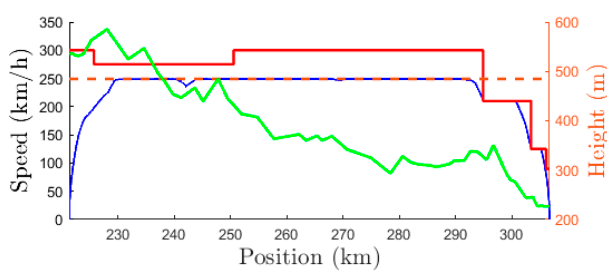
Figure 9. Standard driving speed profile for the commercial time in the Calatayud–Zaragoza section.